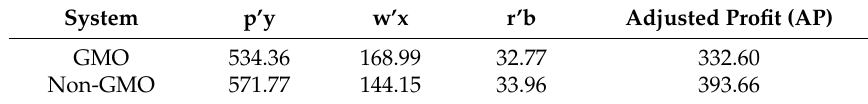
Table 5. Adjusted profit for GMO and non-GMO rice systems.